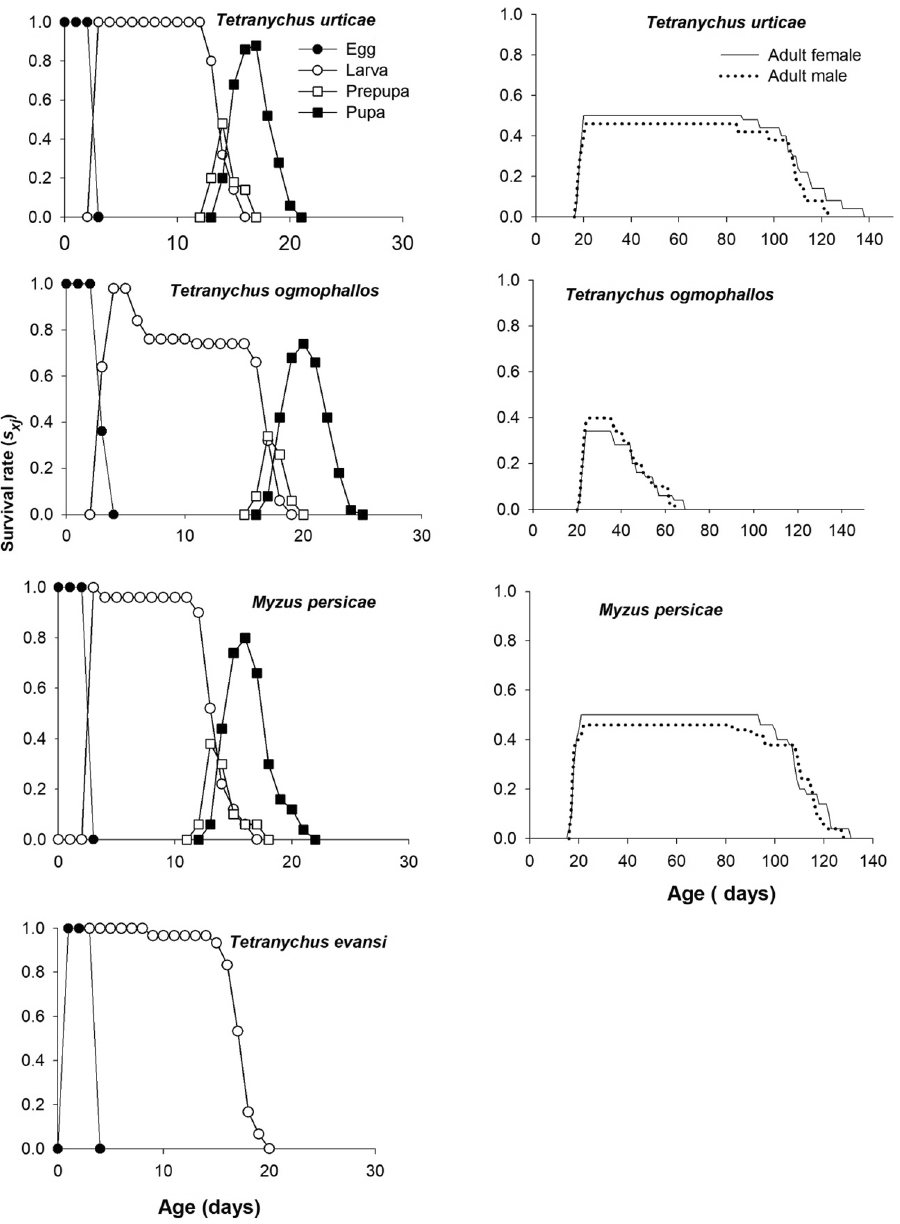
Figure 2. Age-stage-specific survival rate ( s xj ) of Eriopis connexa fed on Tetranychus urticae , Tetranychus evansi, Tetranuchus ogmophallos , or Myzus persicae